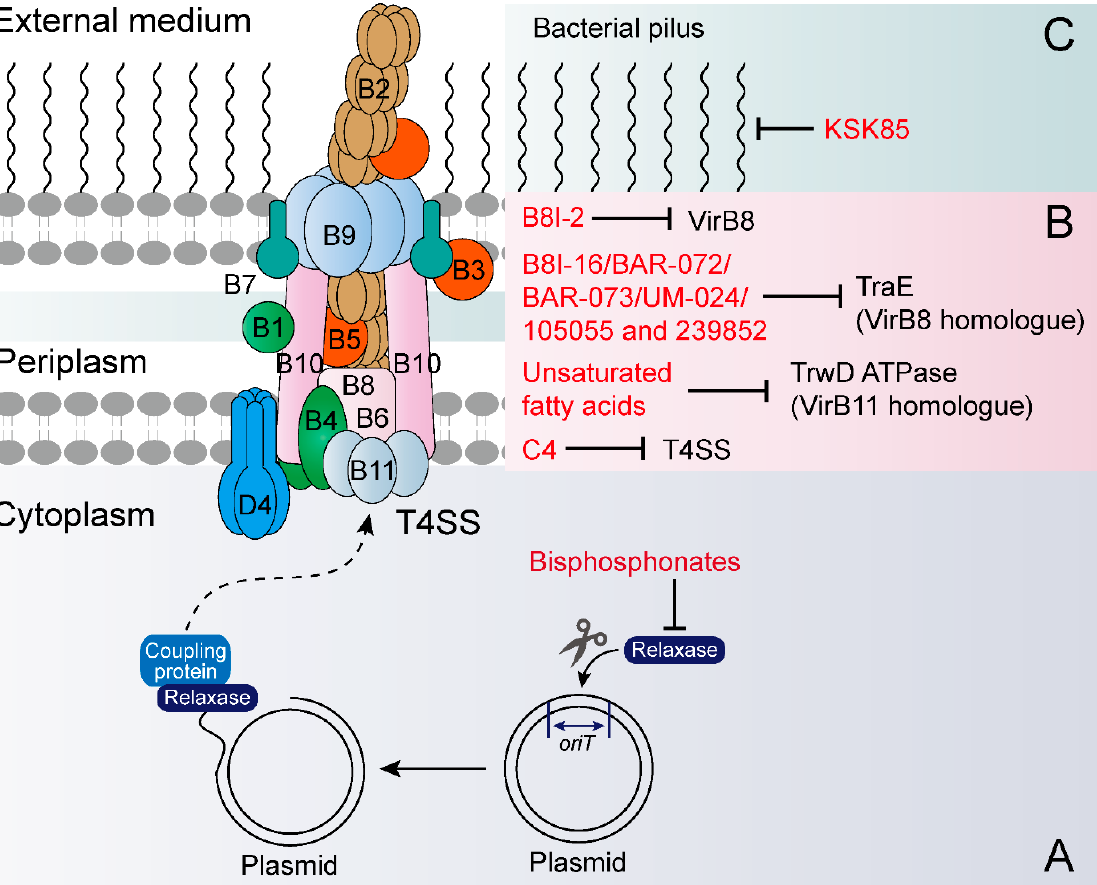
Figure 3. Promising targets of HGT inhibitors on conjugative machinery. Conjugative relaxase protein encoded by the mob gene cleaves plasmid strands at the origin of transfer (oriT) and covalently binds to the DNA at the 5 ′ end. With the assistance of the coupling protein, this nucleoprotein complex is recruited at the secretion channel (T4SS). ( A ) Conjugative relaxase protein initiates conjugation upon nicking plasmid DNA at the origin of transfer, and thereby has been considered as a potential target for HGT inhibitors. ( B,C ) The transportation of DNA is mediated by a type IV secretion system (T4SS), a protein complex (also known as a mating pore formation (MPF)) that consist of substrate transport ( B ) and pilus biogenesis ( C ). Generally, substrate transport comprises 11 proteins, named VirB1 to VirB11. Thus, these proteins and conjugative pilus could be a potential molecular target for HGT inhibitors. 105055, (4-(1H-pyrrol-1-yl)pyridine-2-carboxylic acid); 239852, (2-(2-furyl)isonicotinic